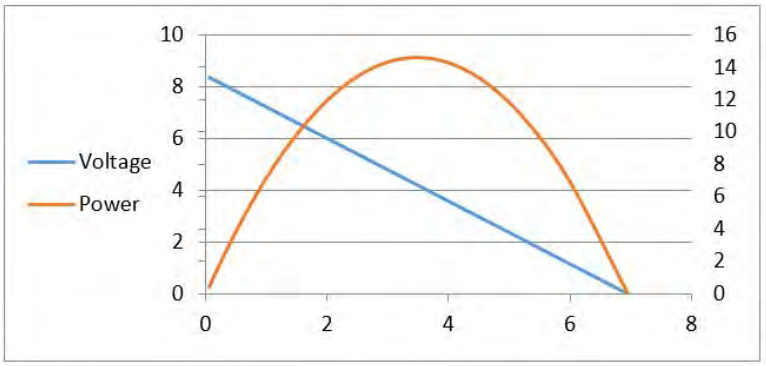
Figure 3. TEG1-12611-6.0Module specifications